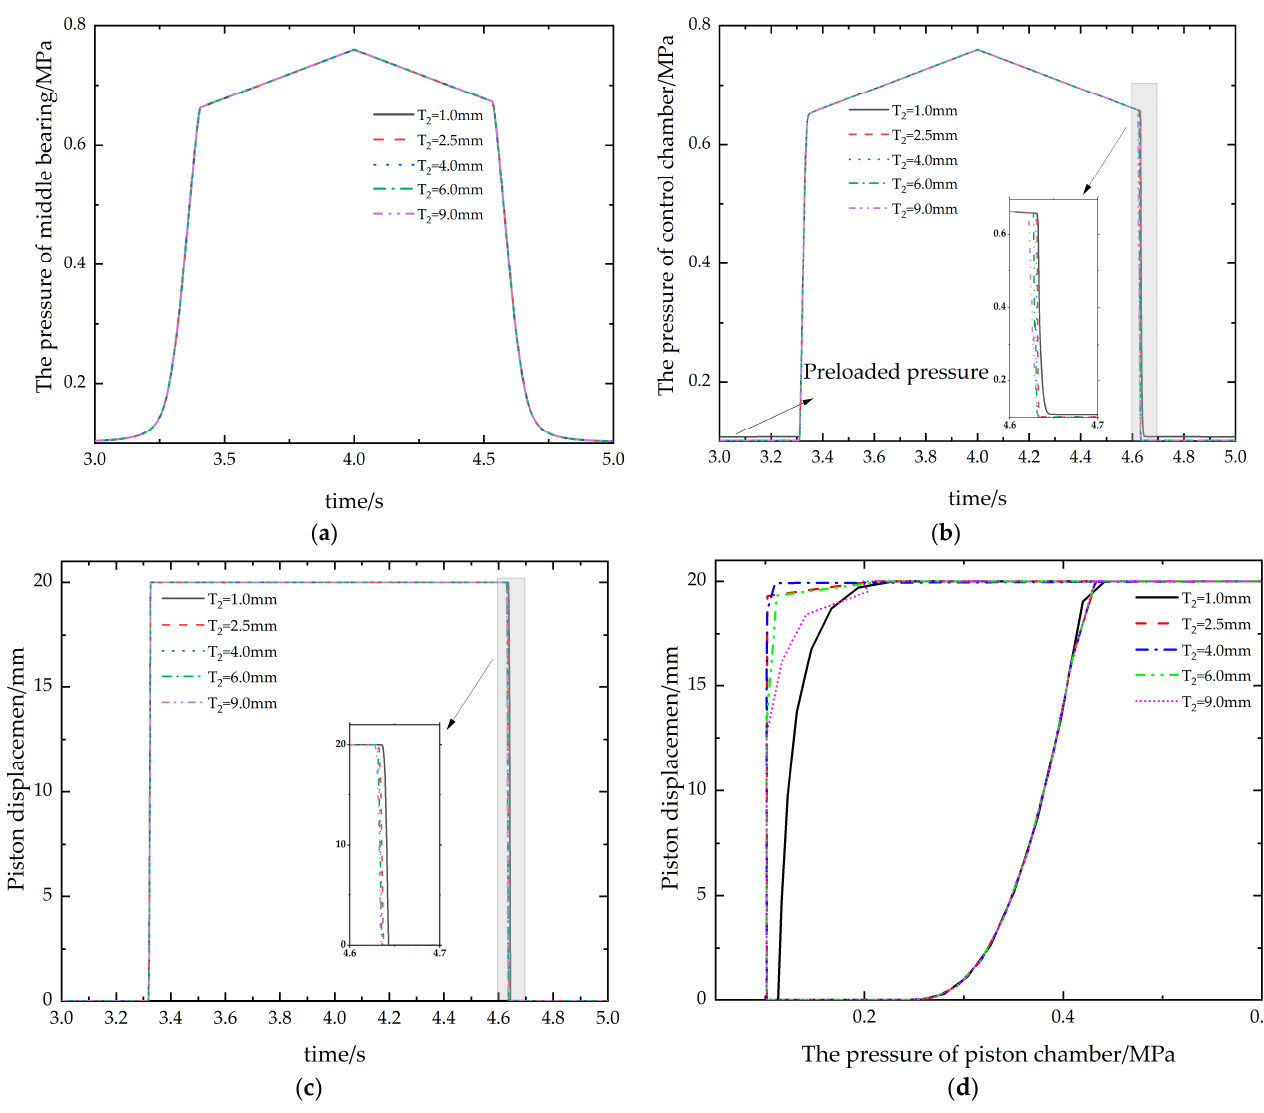
Figure 15. Opening and closing characteristics of valve under different nozzle diameters of middle shell: ( a ) The variation law of middle bearing pressure with time; ( b ) Control of the change in cavity pressure with time; ( c ) The variation law of piston displacement with time; ( d ) The variation of piston displacement with pressure in control chamber.